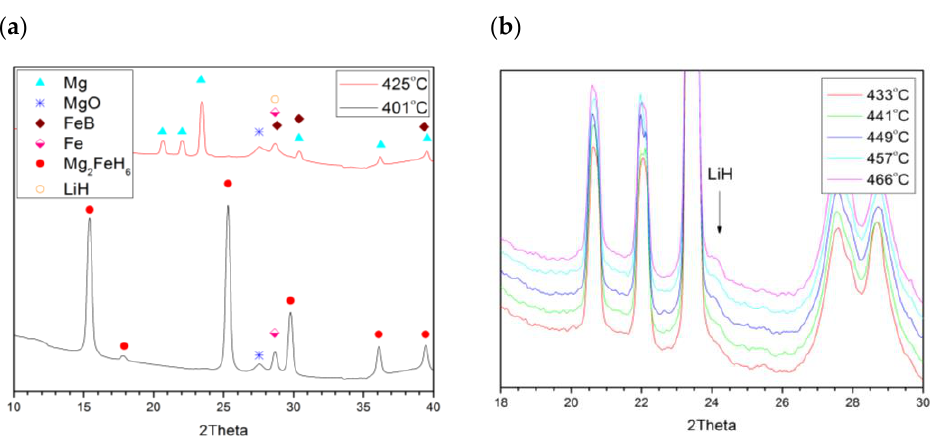
Figure 4. ( a ) Simultaneous A and B reactions ( Mg 2 FeH 6 + LiBH 4 → FeB + 2Mg + LiH + 9/2H 2 ). ( b ) LiH formation due to LiBH4 dissociation at 440 °C.